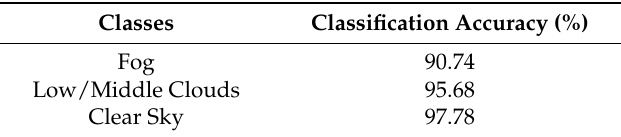
Table 4. Accuracy of the test